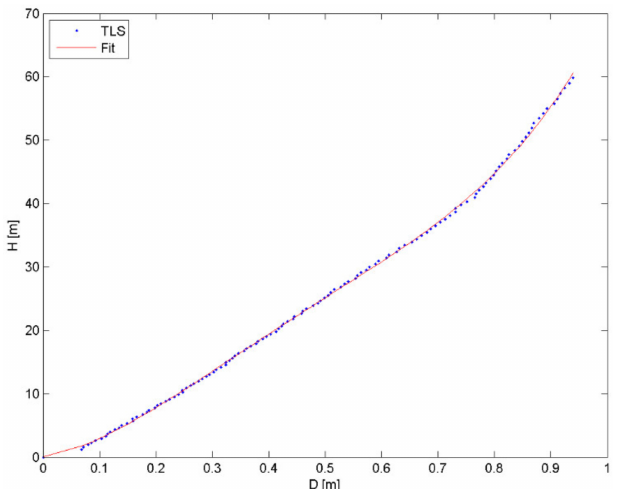
Figure 5. Polynomial fitting of points along the wind tower of a single line